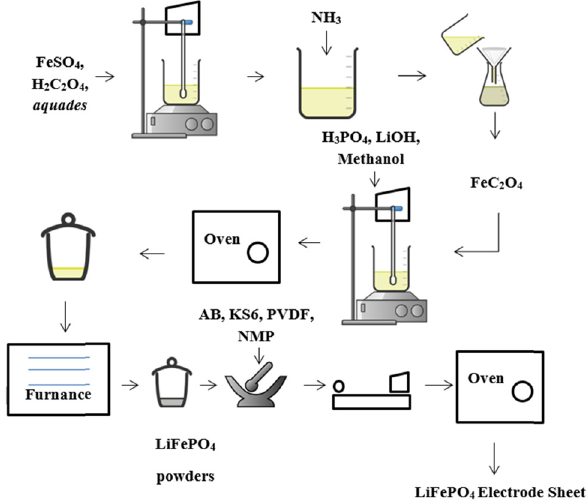
Figure 1: Flow diagrams of LiFePO 4 electrode